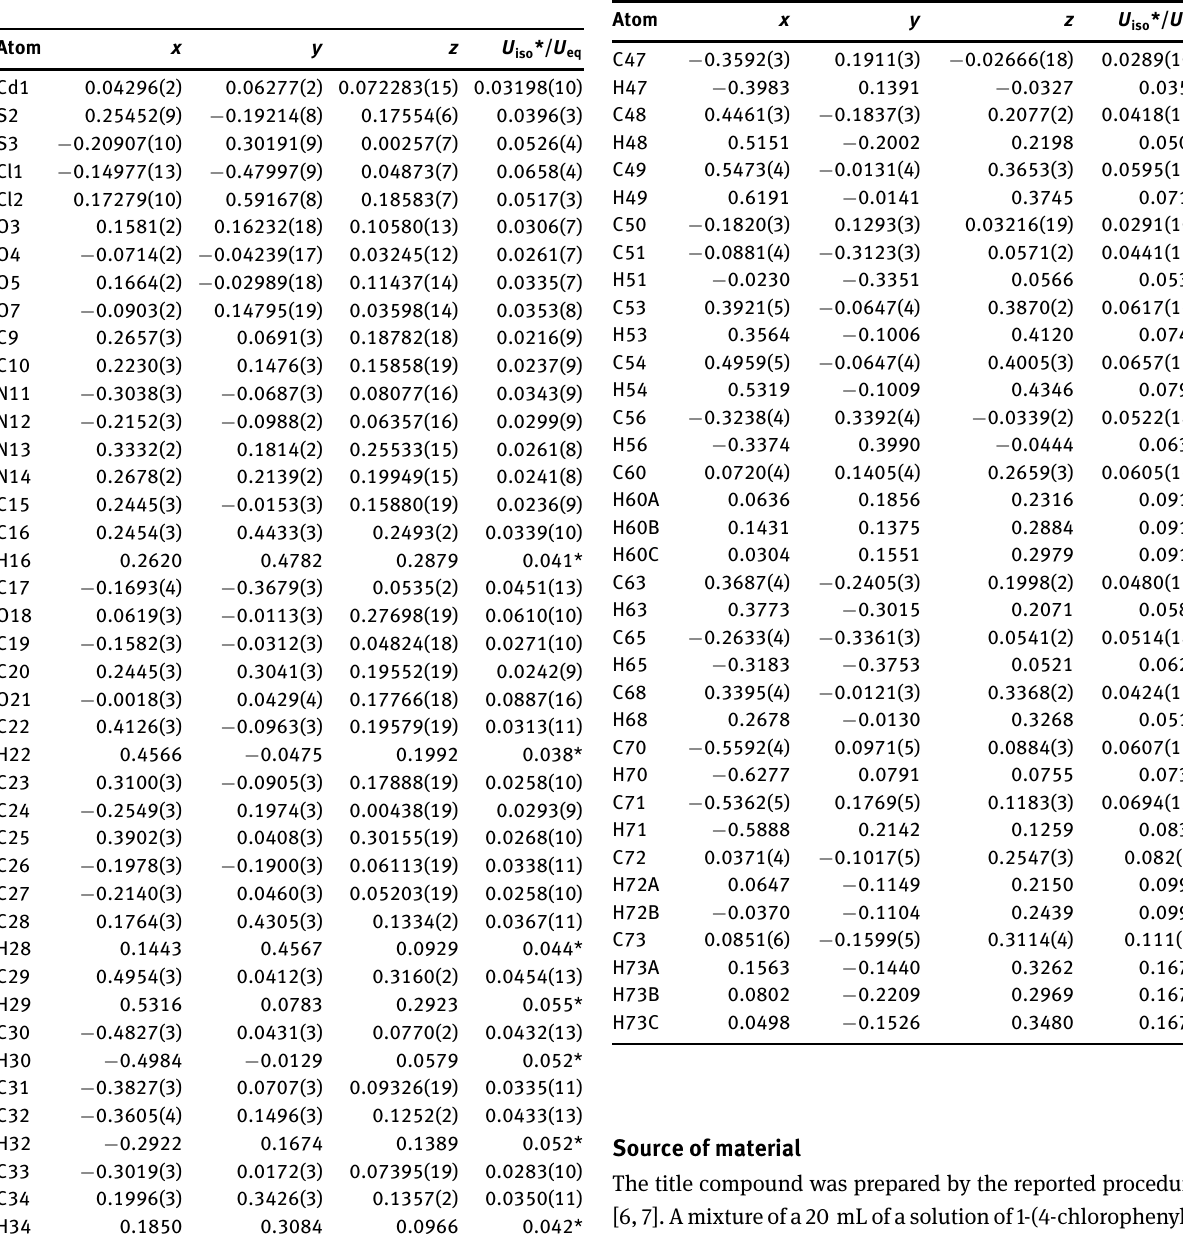
Table 2: Fractional atomic coordinates and isotropic or equivalent isotropic displacement parameters (Å 2